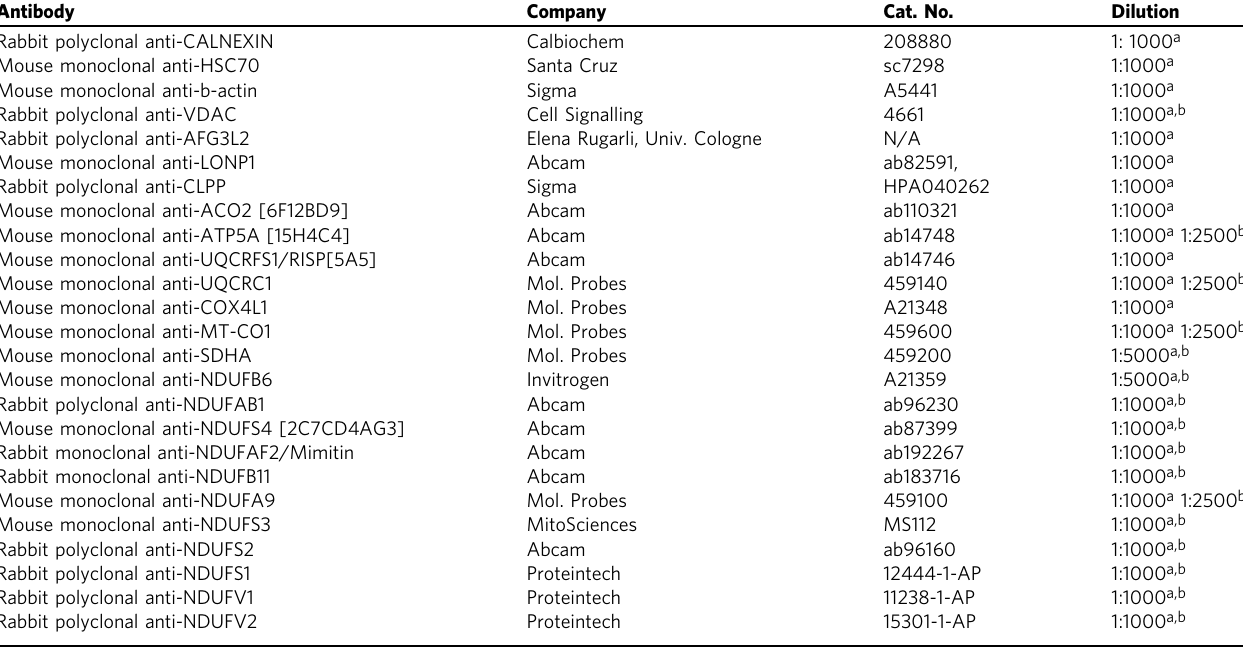
a Dilution for SDS-PAGE/WB. b Dilution for